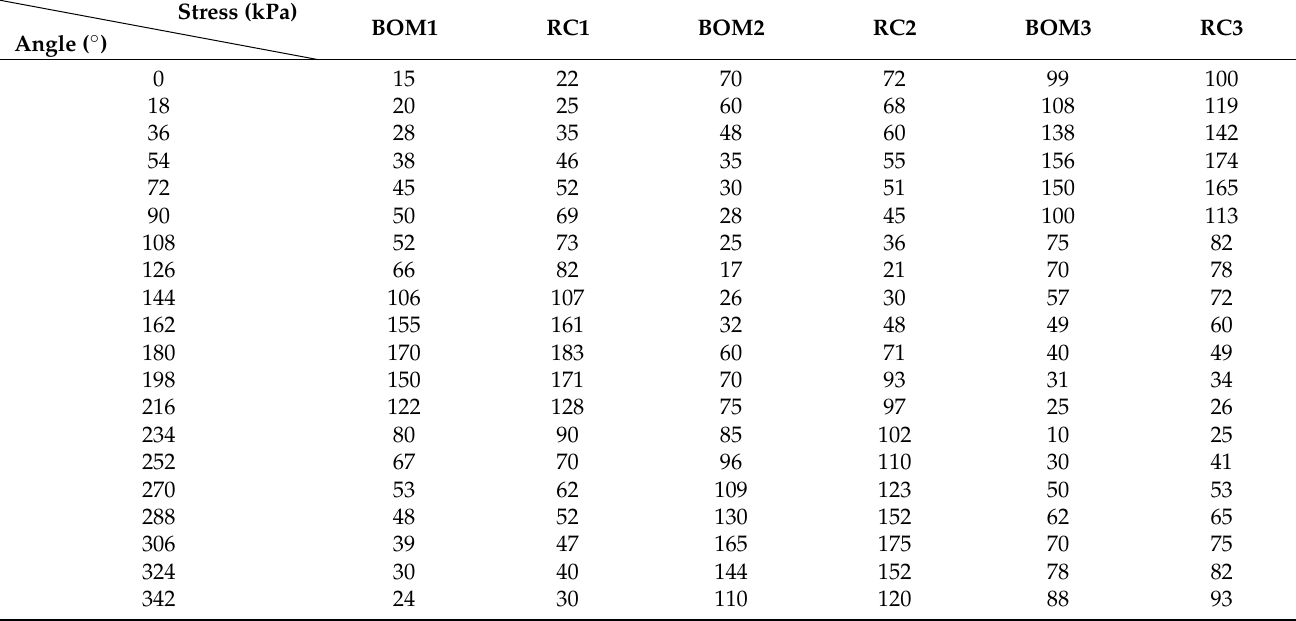
Table A1. The raw data for Figure